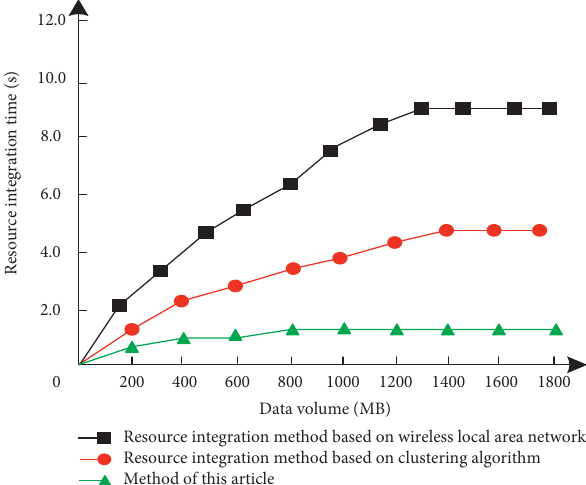
Figure 6: Time-consuming test results of resource